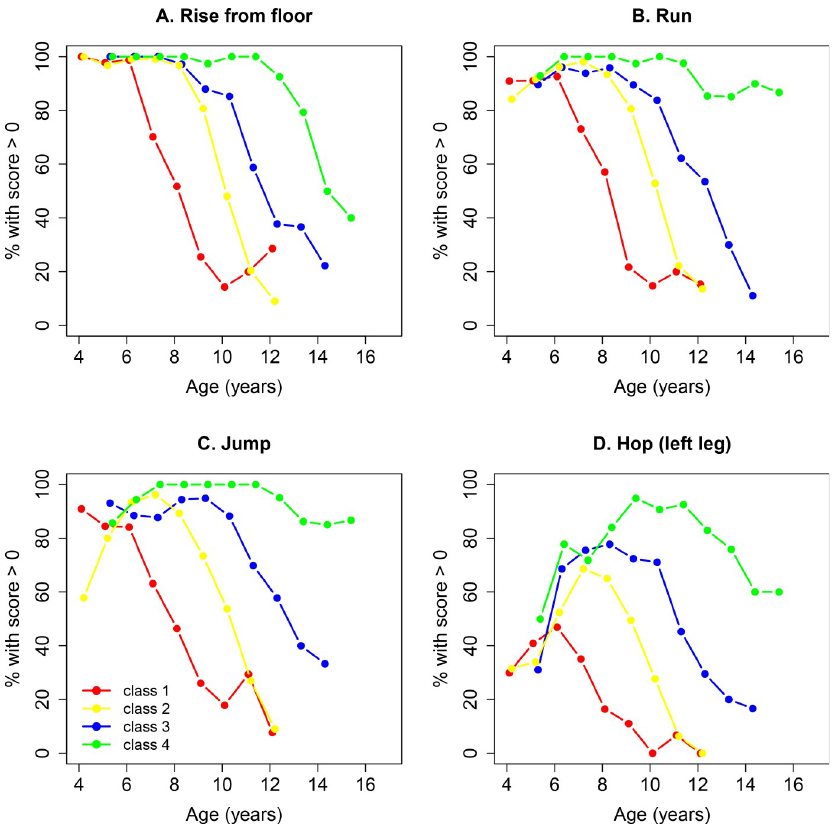
Fig 4. Percentages of patients demonstrating function (NSAA item score > 0) by age and by trajectory class for four of the NSAA items. (A) rise from floor, (B) run, (C) jump, and (D) hop on one leg. NSAA, North Star Ambulatory